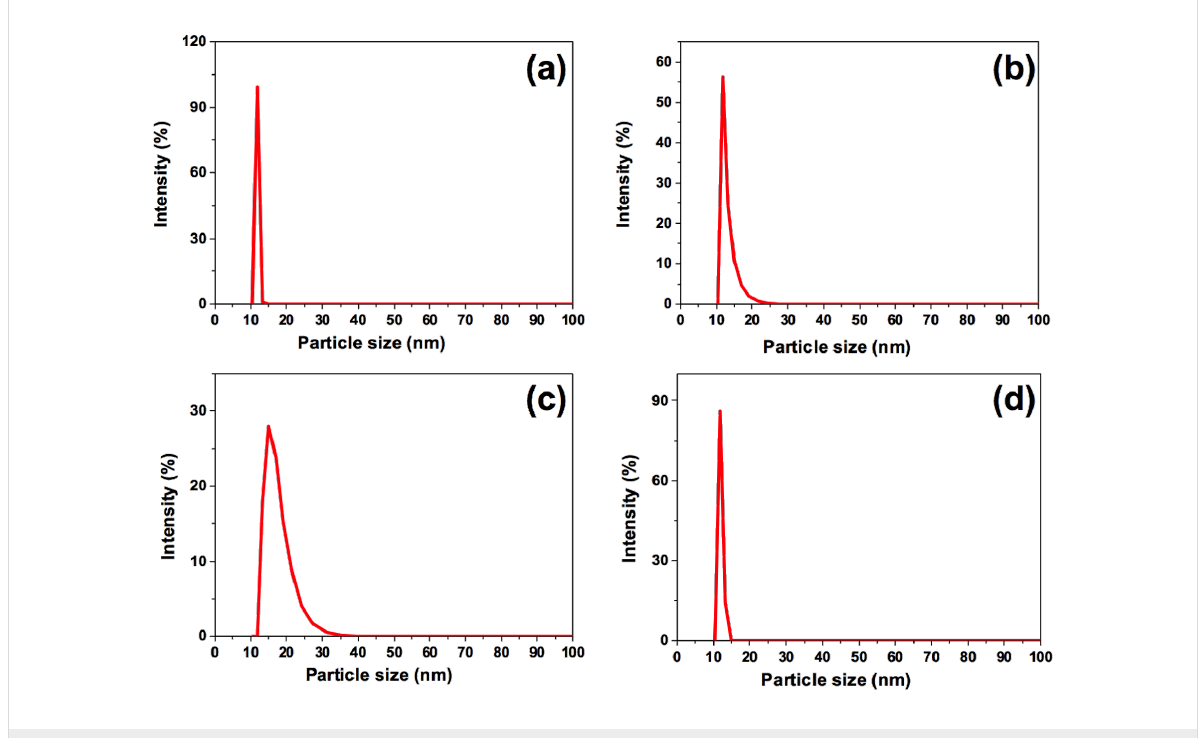
Figure 4: Hydrodynamic radii of (a) cinnamon C-dots, (b) red chilli C-dots, (c) turmeric C-dots and (d) black pepper C-dots obtained through DLS measurements.